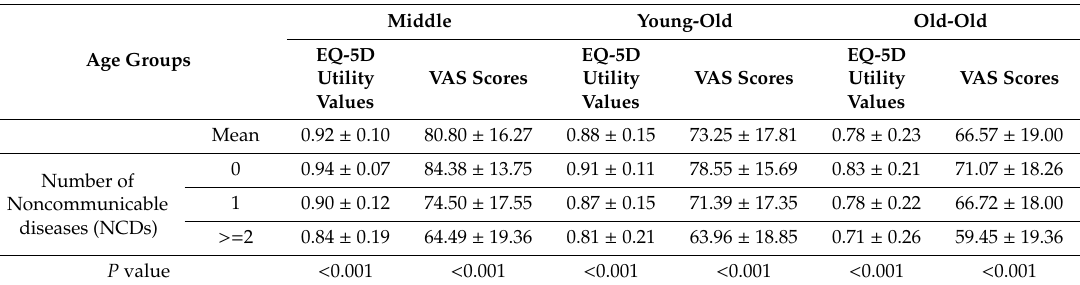
Table 2. The health-related quality of life (HRQOL) of persons with multimorbidity by age groups (mean ± SD).